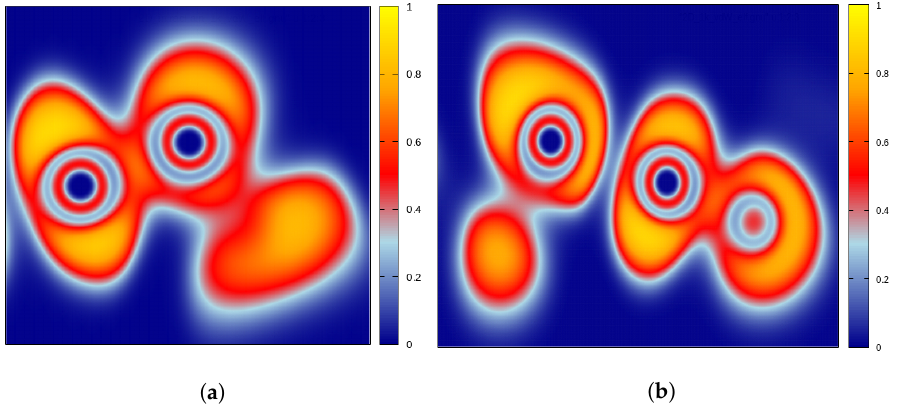
Figure 12. Electron localization function (ELF) for two Te helical chains. Vertical 2D plot cutting through a Te − Te bond axis along a chain ( a ) and between the chains ( b